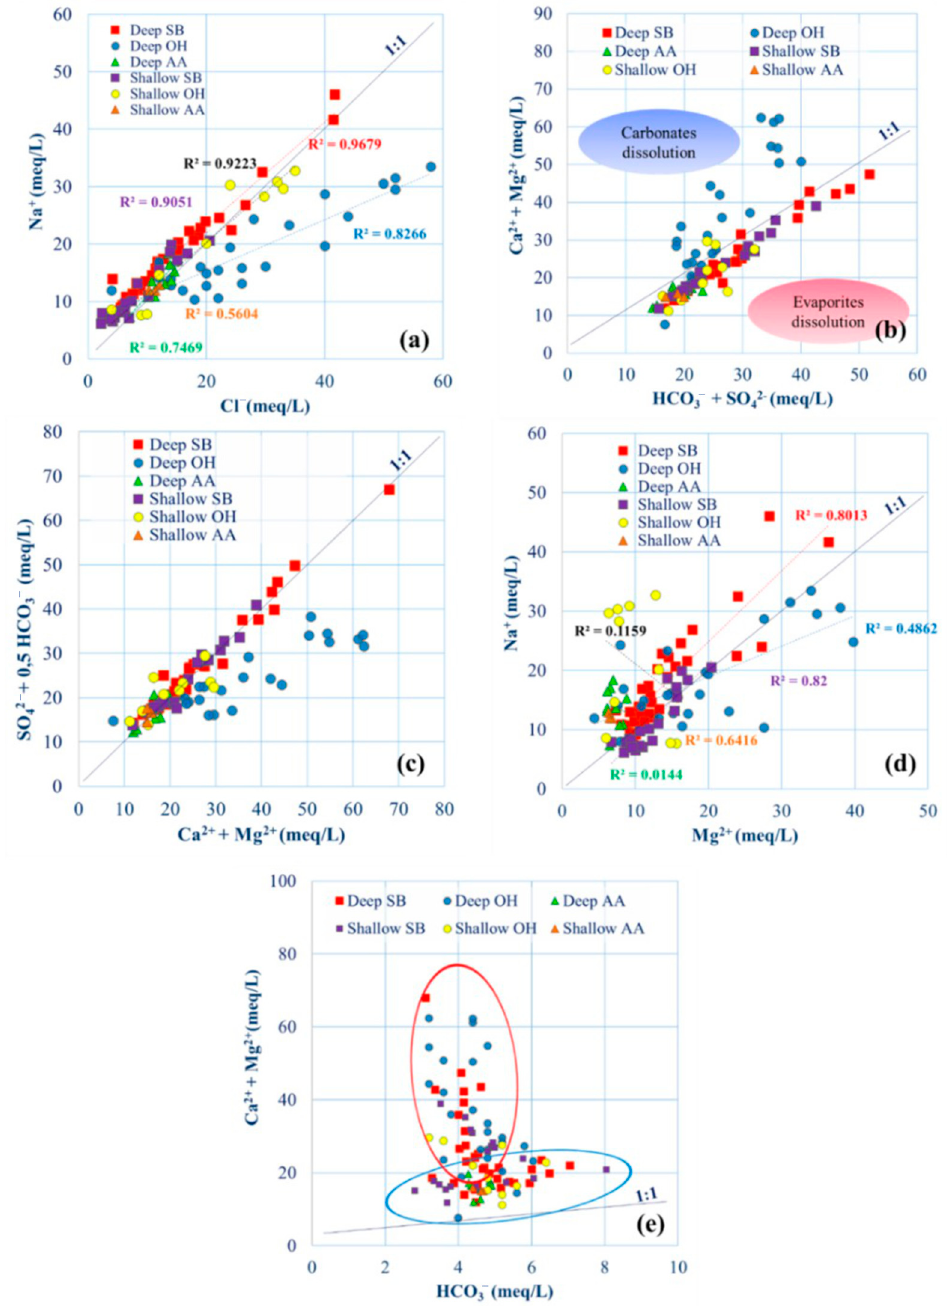
Figure 6. Scatter plots of major ions in the deep and shallow